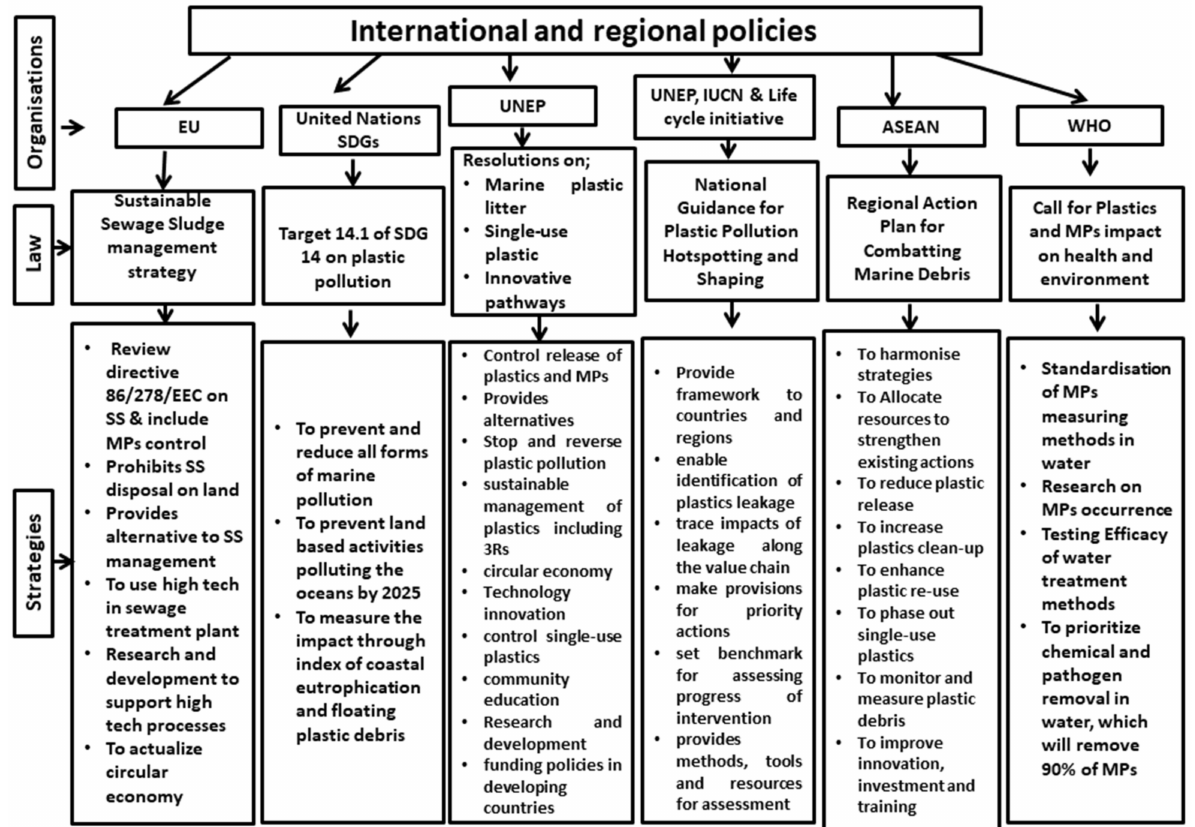
Figure 3. Governance strategies by international and regional organizations to combat plastic and MPs